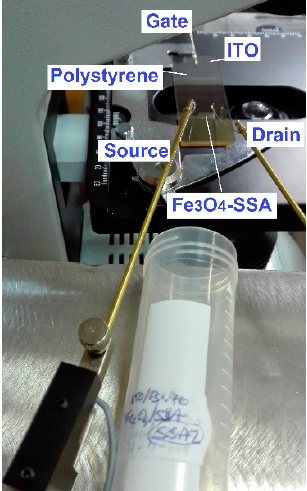
Figure 5. A schematic of the organic thin-film transistor (OTFT) structure, showing the successive layers and the three electrodes places: Gate in contact with the indium tin oxide (ITO), and the source and drain in contact with the Fe 3 O 4 –SSA film.